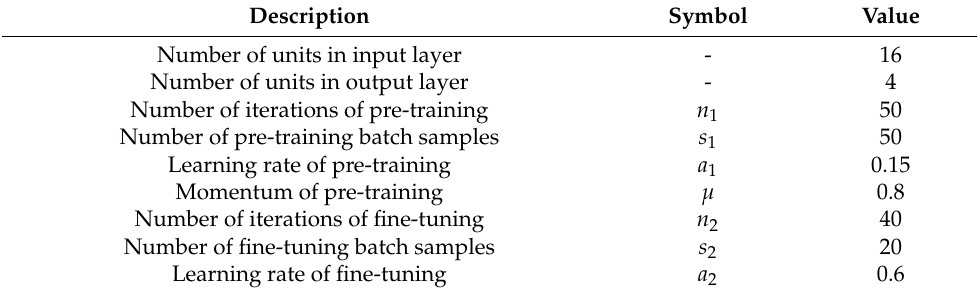
Table 2. The parameters of DBN.